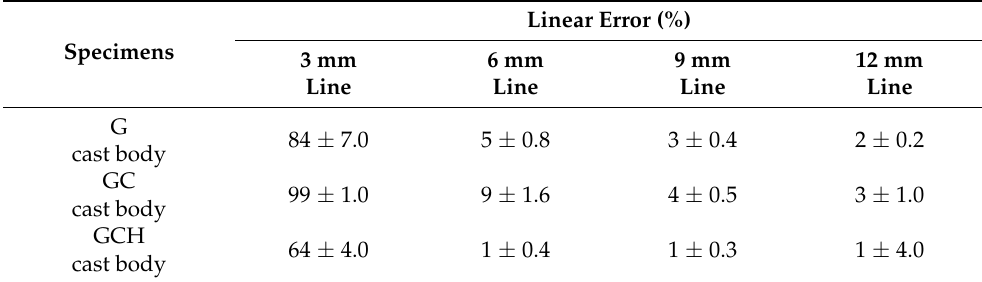
Table 2. Hand-shaped mold casting rice for each process according to the gap diameter of the mold (%).